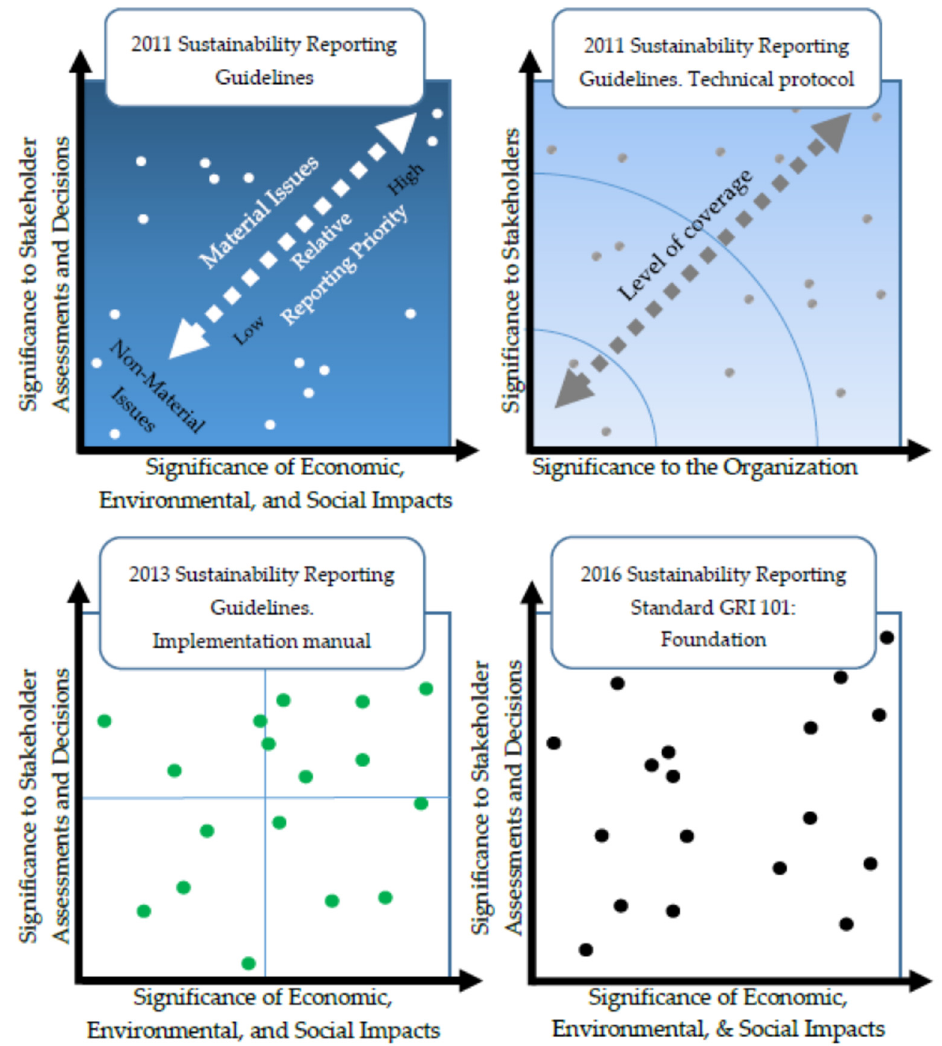
Figure 2. GRI materiality matrices, 2011–2016: a rielaboration of the graphical formats.